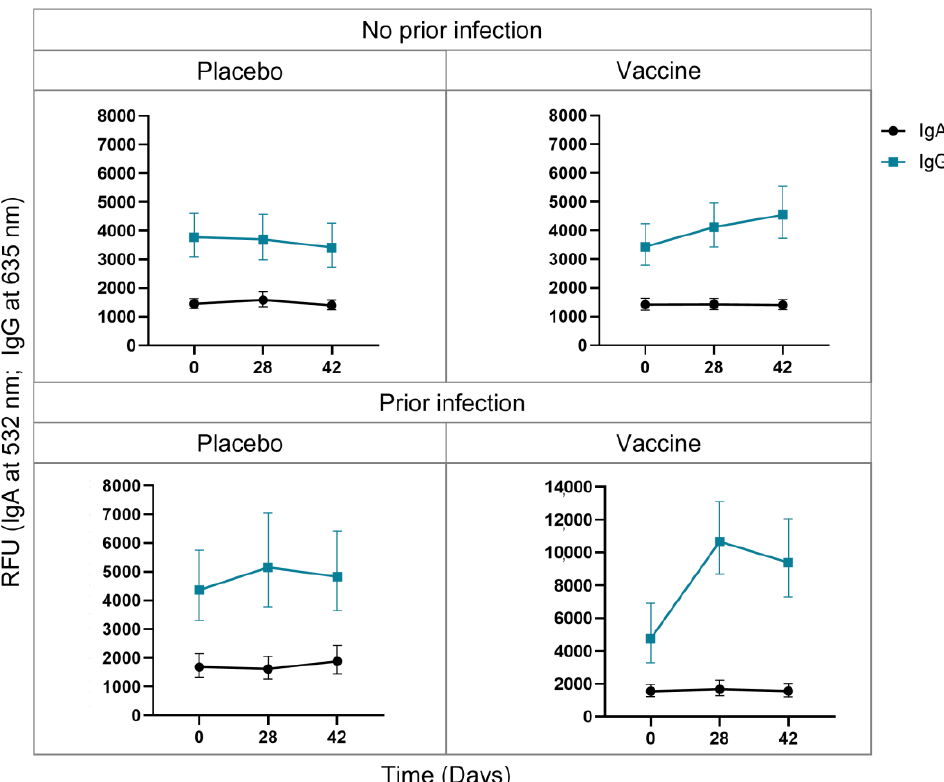
Figure 1. Longitudinal (Day 0, Day 28 and Day 42) change in IgA and IgG against the SARS-CoV-2 ancestral spike (S) protein in response to the ChAdOx1 nCoV-19 vaccinated in Black people living with HIV (PLWH). Participants were vaccinated at Day 0 and Day 28, and serum collected before vaccine administration at Day 0, Day 28 ad Day 42, and assessed based on division into a placebo or vaccine-receiving groups, with or without a prior infection. The average relative fluorescence unit (RFU) is represented and the error bars indicate the minimum and maximum RFU values.